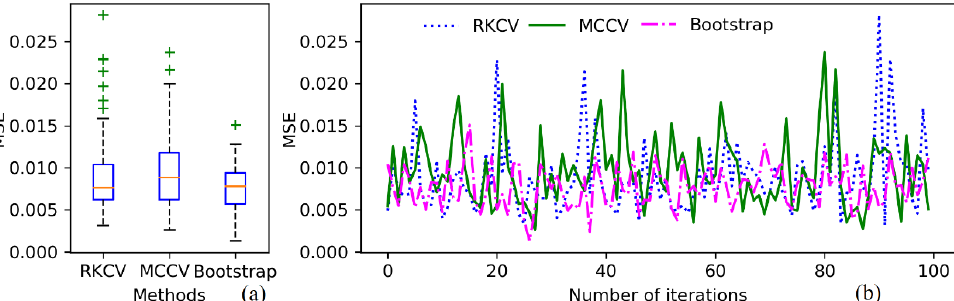
Figure 3 . Results of R k -CV, MC-CV and bootstrap for 100 synthetic data sets: (a) Boxplots for the MSE values, (b) line diagrams for MSE versus number of iterations.